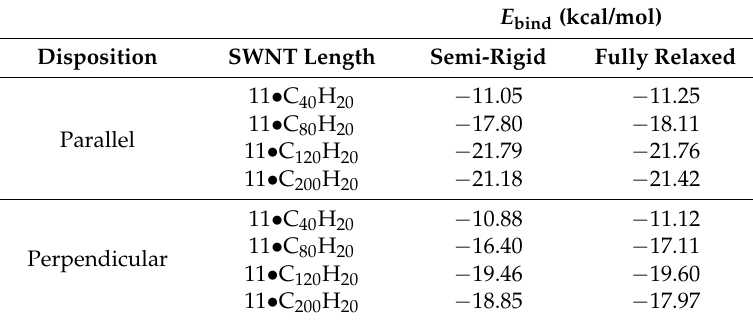
Table 8. Binding energy depending on the nanotube length for the parallel and perpendicular dispositions of the supramolecular 11 • SWNT complex calculated at the PBE0-D3/6-31G** level of theory [117].